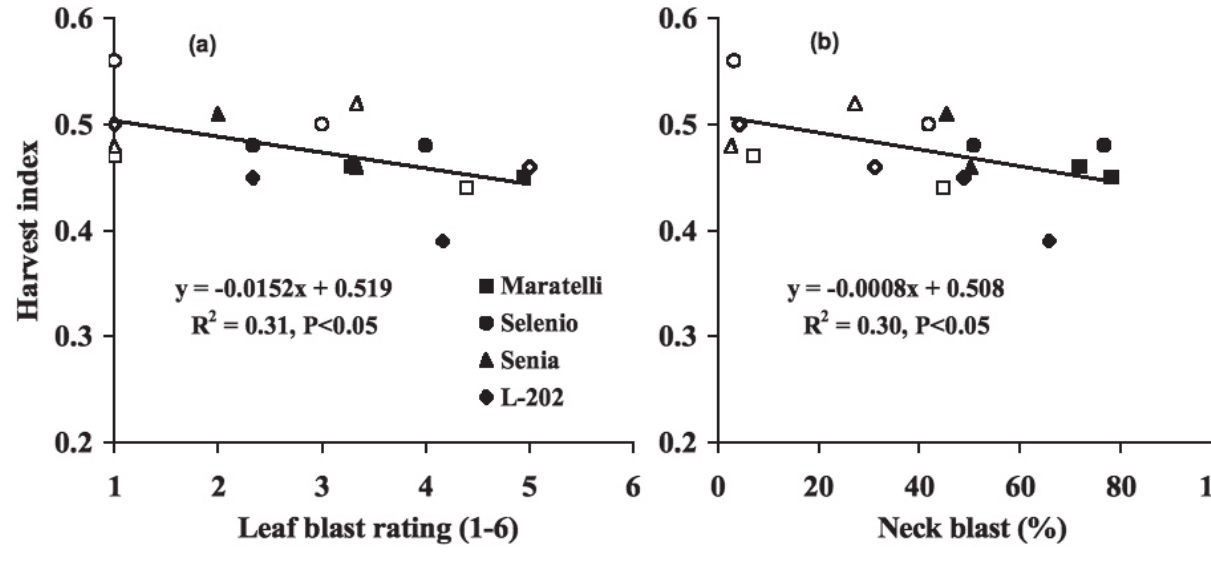
Fig. 3. Relationship (a) between leaf blast rating 80 days after inoculation and the harvest index; (b) between neck blast infection 55 days after the time of 50% heading and the harvest index in rice. Each relationship was based on the means derived from four rice varieties, two disease treatments and two years (2003, filled symbols; 2004, empty symbols) of experimentation